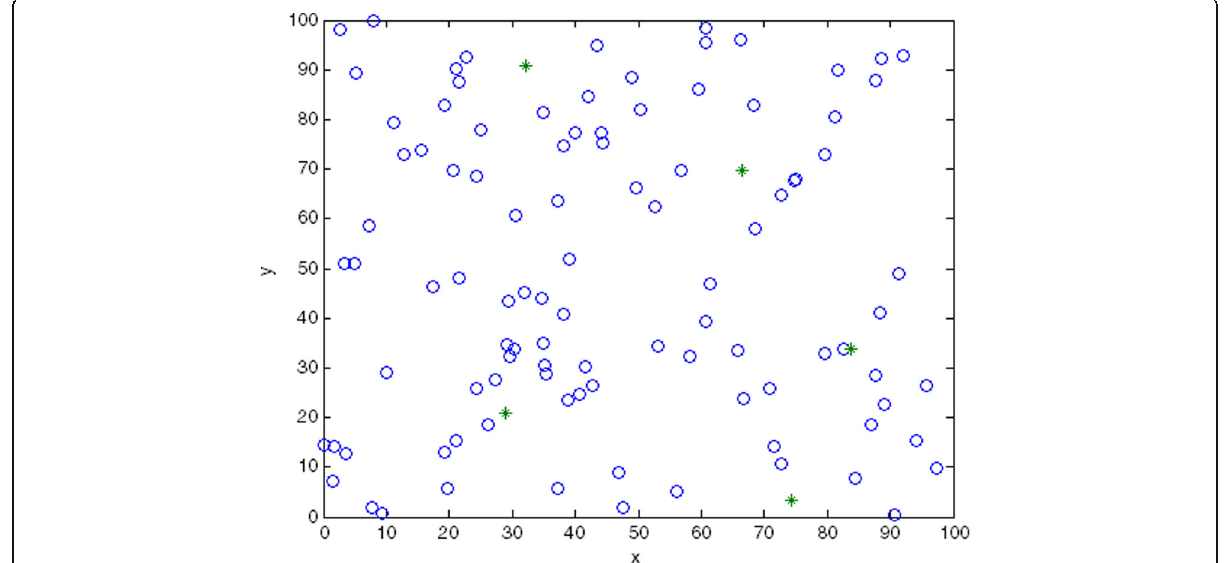
Fig. 6 Example of nodes distribution which contains the unknown nodes (dots) and anchor nodes